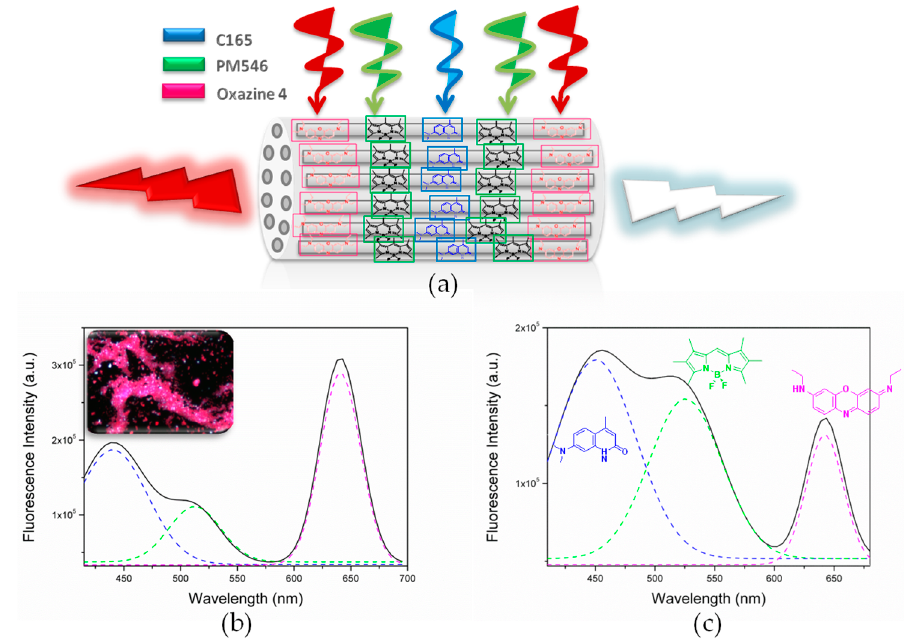
Figure 5. ( a ) Schematic representation of the antenna material prepared by the sequential insertion of three different dyes into disc-shaped LTL zeolite channels. Fluorescence spectrum of ( b ) C165(10%)-PM546(10%)-Ox4(10%)- and ( c ) C165(10%)-PM546(10%)-Ox4(2%)-doped LTL zeolites recorded upon selective excitation of the first donor at 375 nm (dashed lines account for the emission of each free dye). Inset in ( b ): fluorescence image of agglomerated dye-doped zeolite crystals under 350/50-nm excitation and recording the emission with a long-pass filter of 400 nm.